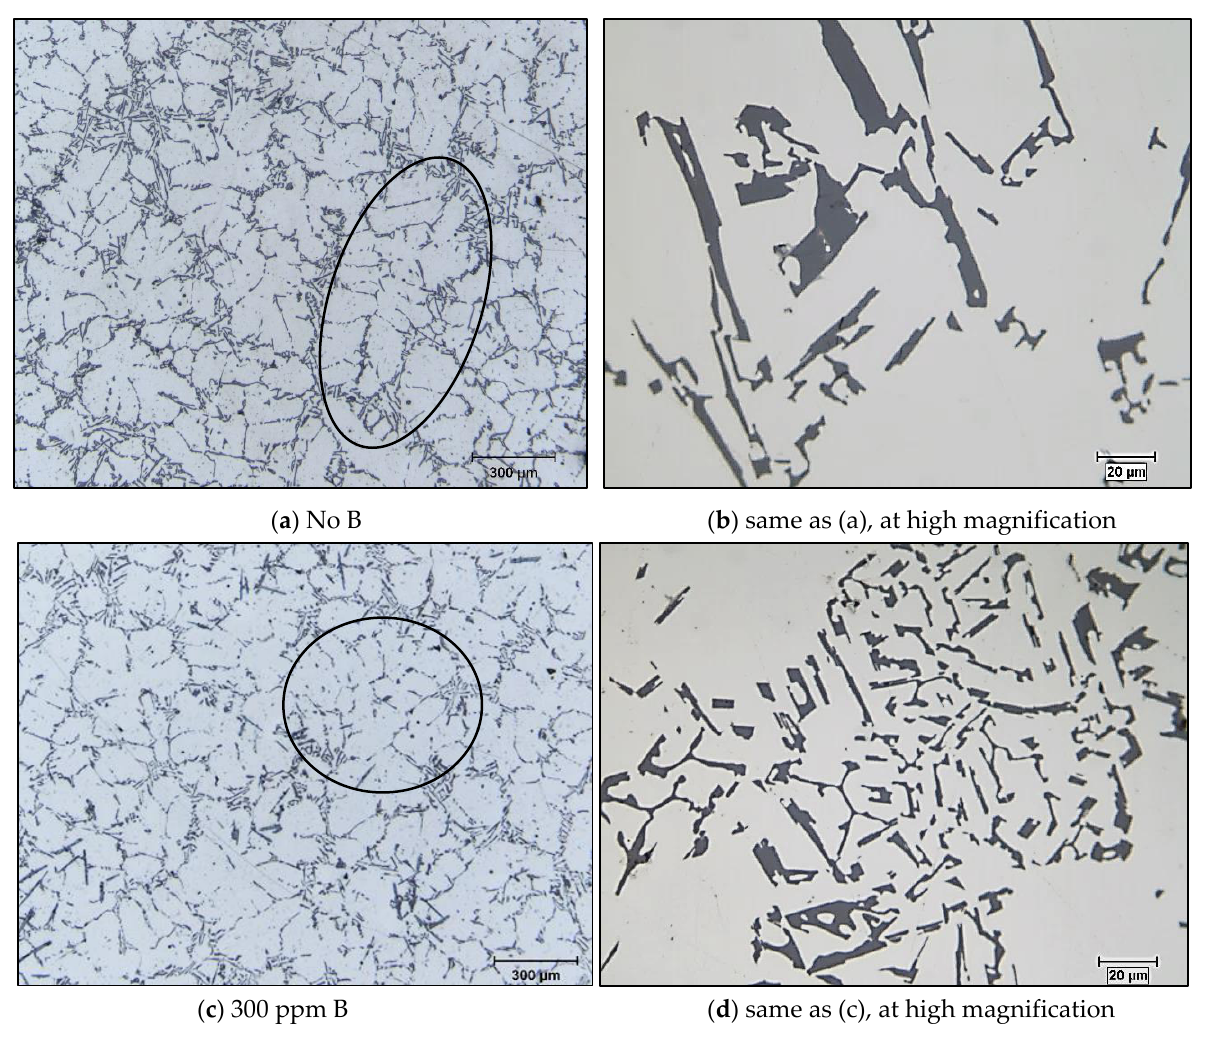
Figure 15. Optical microstructure of the A356 base alloy following treatment with B: ( a ) as received alloy showing elongated dendrites (see black circle); ( b ) acicular eutectic Si particles in ( a ); ( c ) 300 ppm B showing rounded dendrites (see black circle); ( d ) partially modified Si particles in ( c ).